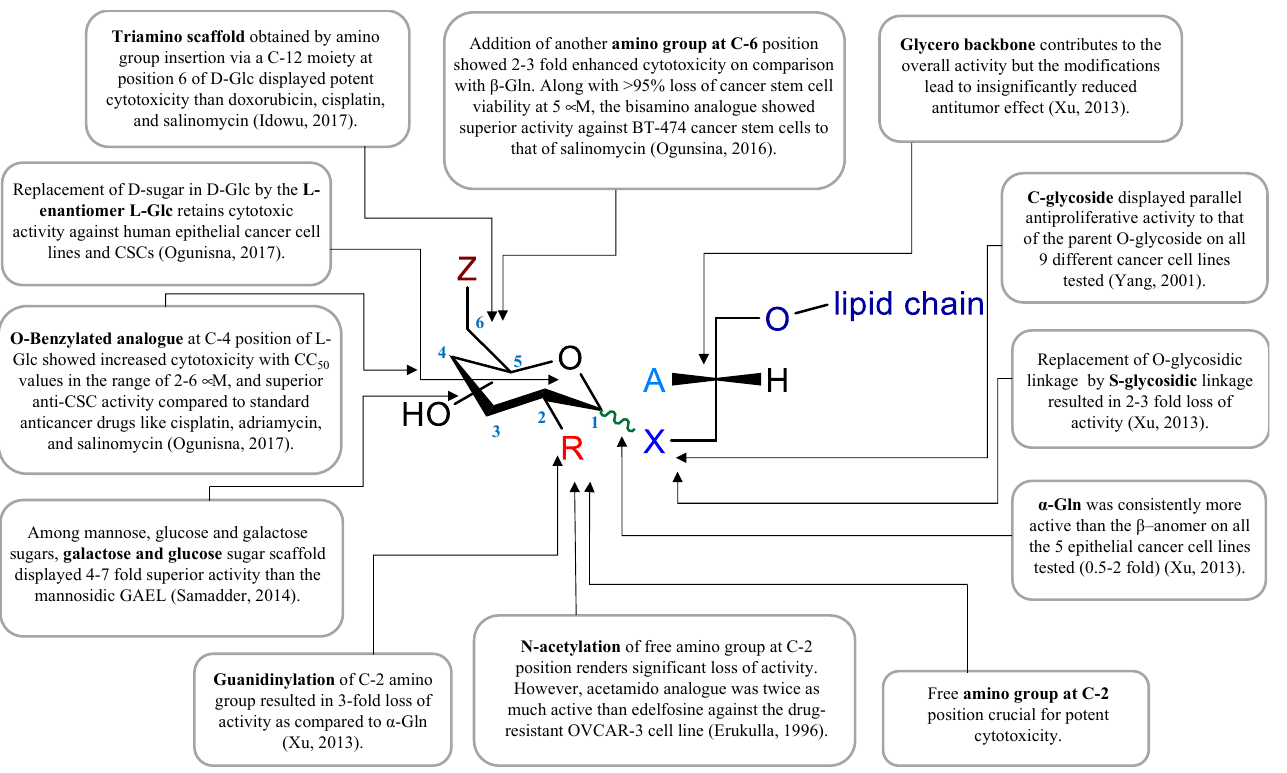
Figure 3. GAEL structure–activity relationship map. Data compiled from references [50,52,88,90–92,94].